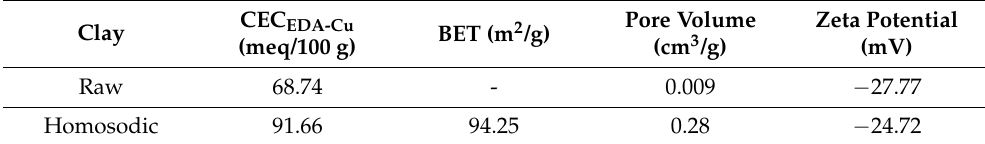
Table 1. The main parameters determined for the raw and homosodic clay. CEC: is the cationic exchange capacity using the copper ethylene diamine complex [Cu (EDA)2]2 + and BET: specific surface of clays. CEC EDA-Cu Pore Volume Zeta Potential Clay BET (m 2 /g) (meq/100 g) (cm 3 /g) (mV) Raw 68.74 - 0.009 − 27.77 Homosodic 91.66 94.25 0.28 − 24.72 Rosmarinus officinalis L. essential oil (REO) was obtained from a distillation unit